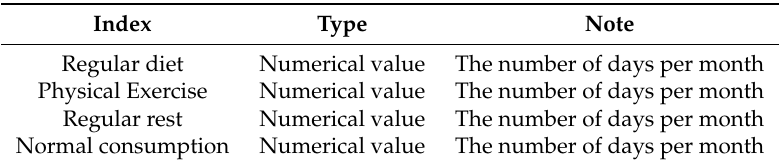
Table 1. Evaluation indexes of living habit.